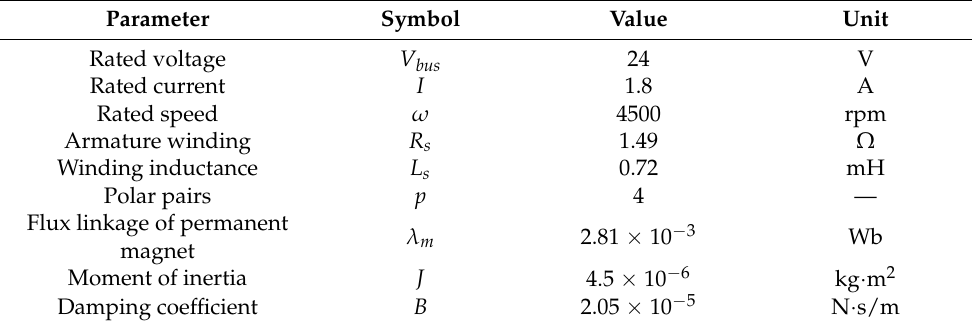
Table 3. Motor parameter identification